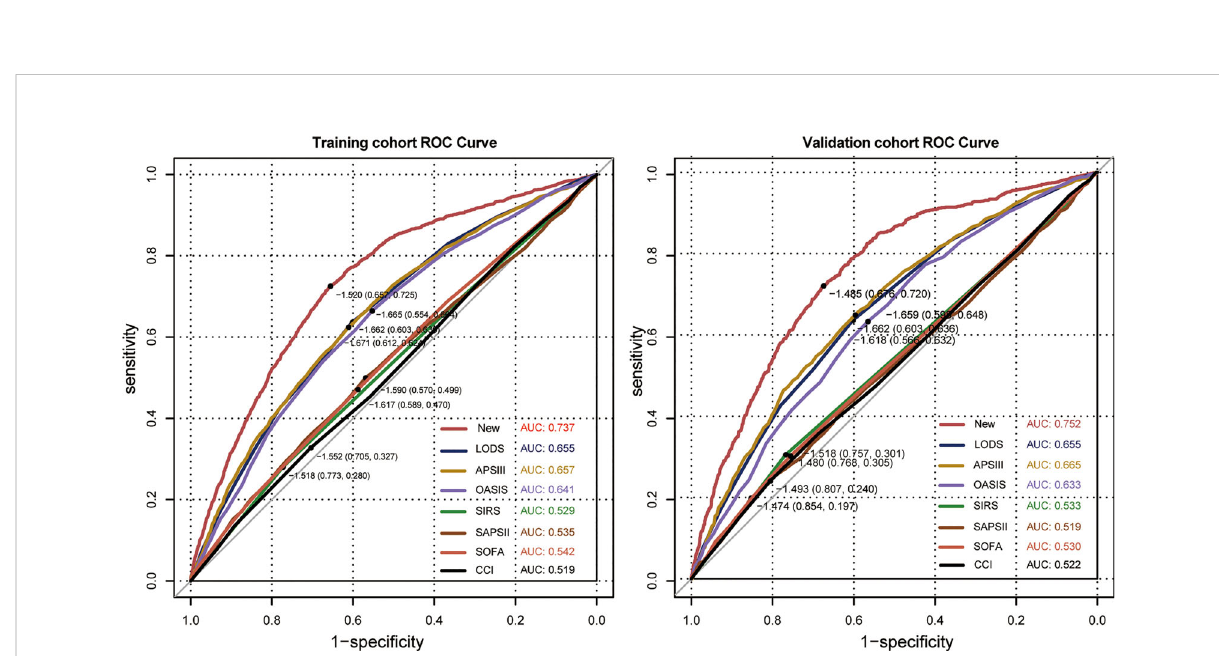
FIGURE 6 Corresponding receiver operating characteristic (ROC) curves of models in the training cohort and the validation cohort. The new model is the multivariate logistic regression model. LODS, Logistic Organ Dysfunction Score; APS III, Acute Physiology; OASIS, Oxford Acute Severity of Illness Score; SIRS, Systemic In fl ammatory Response Syndrome Score; SAPS II, Simpli fi ed Acute Physiology Score II; SOFA, Sequential Organ Failure Assessment; CCI, Charlson Comorbidity Index.